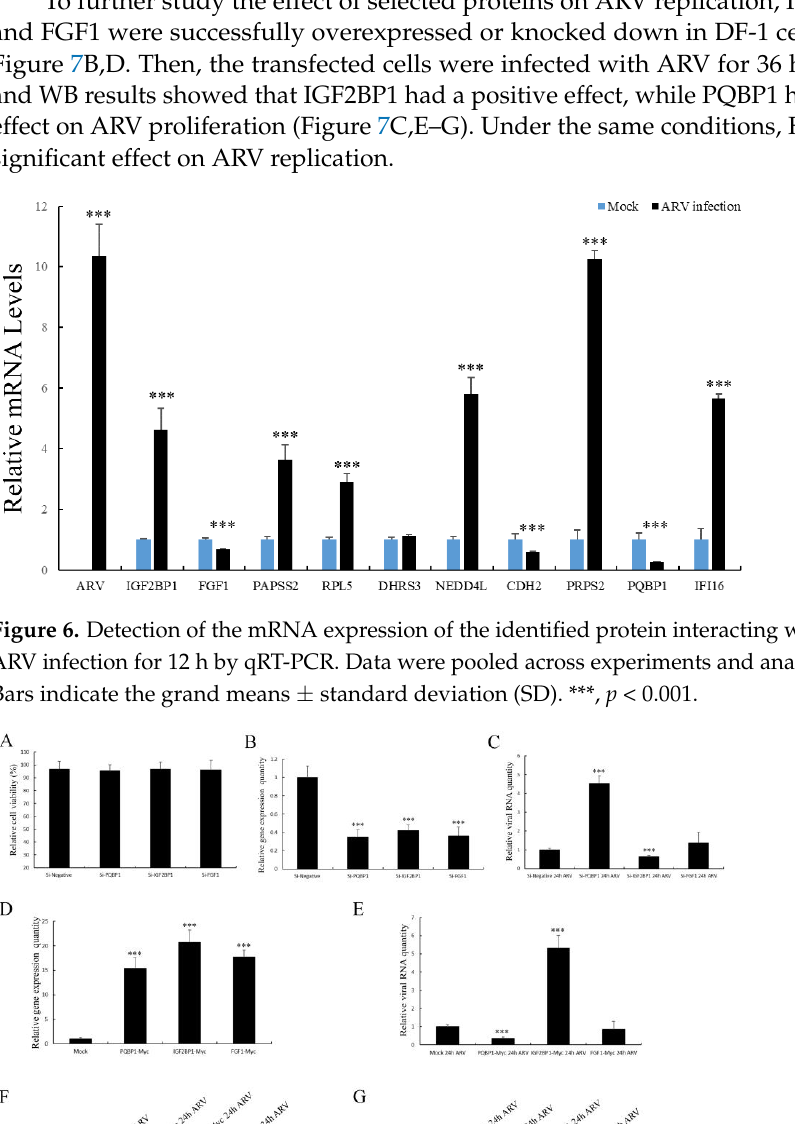
Figure 7. The effect of the selected proteins on ARV replication. ( A ) An MTT assay assessed cell viability. ( B ) Knockdown of IGF2BP1, PQBP1 and FGF1 mediated by siRNA. ( C ) The replication level of ARV assessed by qRT–PCR. ( D ) Overexpression of IGF2BP1, PQBP1 and FGF1 mediated by